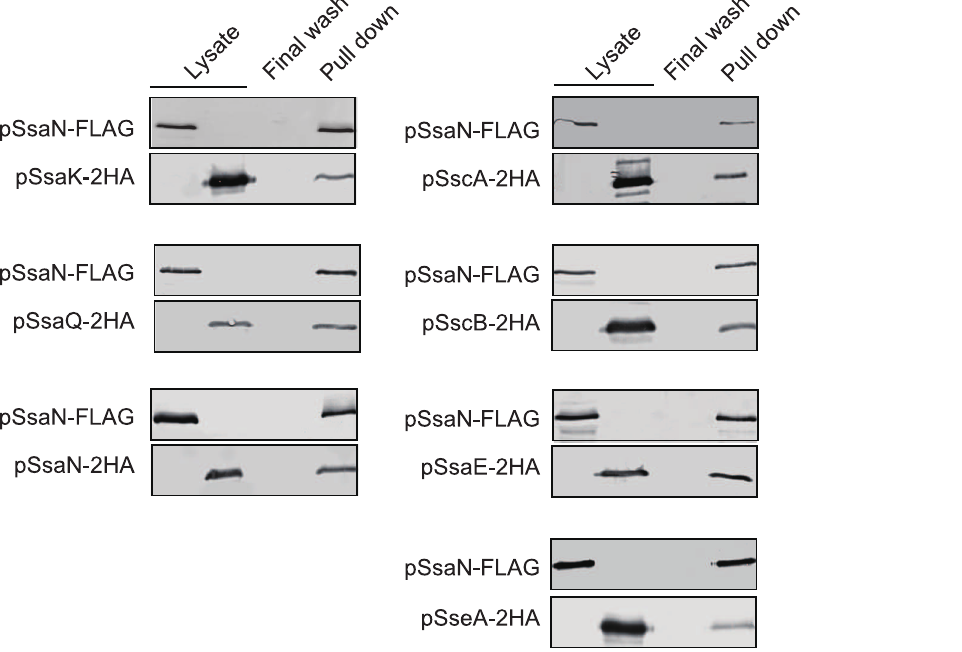
Figure 4. SsaN interactions with the T3SS-2 C-ring components SsaK and SsaQ (A) and T3SS-2 specific chaperones (B). SsaN interactions with different proteins were analyzed using FLAG pull-down assays. SsaN-FLAG was expressed in E. coli strains. SsaN-FLAG fusion proteins in lysates were immobilized using anti-FLAG affinity beads. Bacterial lysates from E. coli strains that expressed SsaK-2HA, SsaQ-2HA, SsaN-2HA, SscA- 2HA, SscB-2HA, SsaE-2HA, and SseA-2HA were then incubated with SsaN-FLAG immobilized-beads. After a final washing with beads (Final wash), protein-binding affinity beads were eluted by adding FLAG peptides. Lysates and eluted proteins (Elute) were detected with anti-FLAG and anti-HA antibodies.